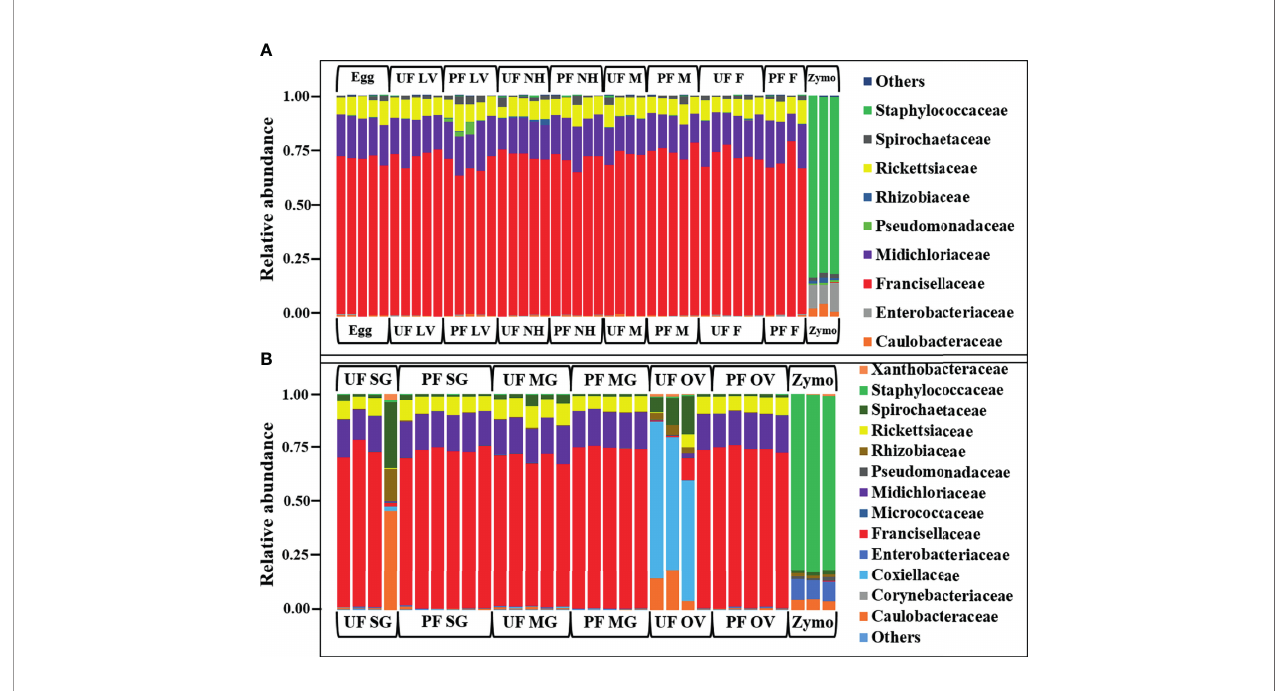
FIGURE 2 | Relative abundances of bacteripro fi les showing the topmost abundant bacteria families to the right ofthe graphs. Each bar represents a single biological replicatefromdifferent (A) developmental stages and (B) isolated tissue from laboratoryraise unfed (UF)and partially fed (PF) Amblyomma americanum ticks. The family Francisellaceaeis the most dominant group occurringat an abundanceof 62% to 80% across the tick developmental stages (A) and10% to 77% across isolatedtissues irrespective of the bloodmeal. The family Coxiellaceae was detected in three of the four replicates fromthe unfed ovarian tissues (UF-OV) at a relativeabundance of 55% to 72% (B) . (UF, unfed; PF,partially-fed;LV, larvae; NH, nymph;M,male; FM, female; SG,salivarygland; MG, midgut; OV, ovary; Zymo, positive bacteria